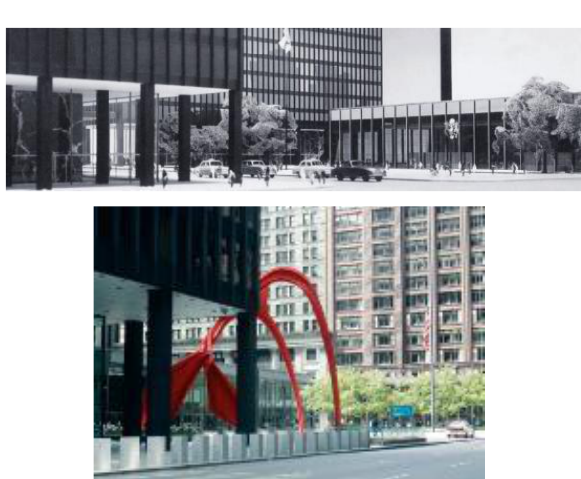
Figure 4. Security protection has been designed in harmony with the architectural identity of the building. The Federal Complex containing the three iconic buildings of Mies van der Rohe and the statue of Alexander Calder (Chicago,